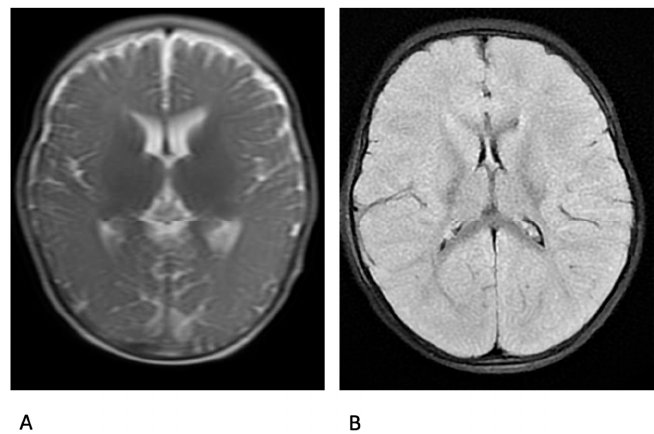
Figure 1. Brain MR of patient #6. ( A ). Axial T2 weighted MR at 6 months of age with no abnormalities. ( B ). Axial T1 weighted MR after 20 h from SE onset, showing di ff use brain